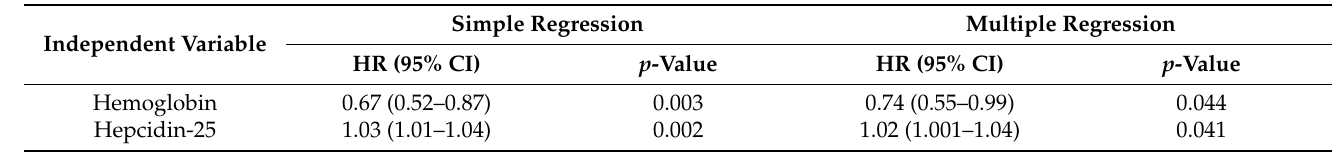
Table 5. Simple and multiple Cox proportional hazard regression model to predict two-year overall survival of studied patients with